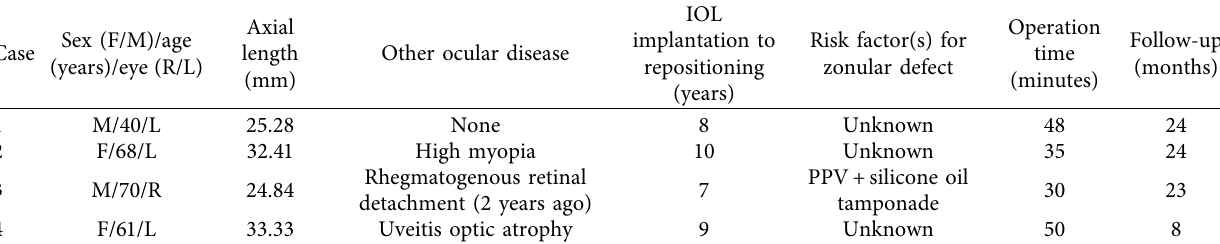
Table 1: Individual patient